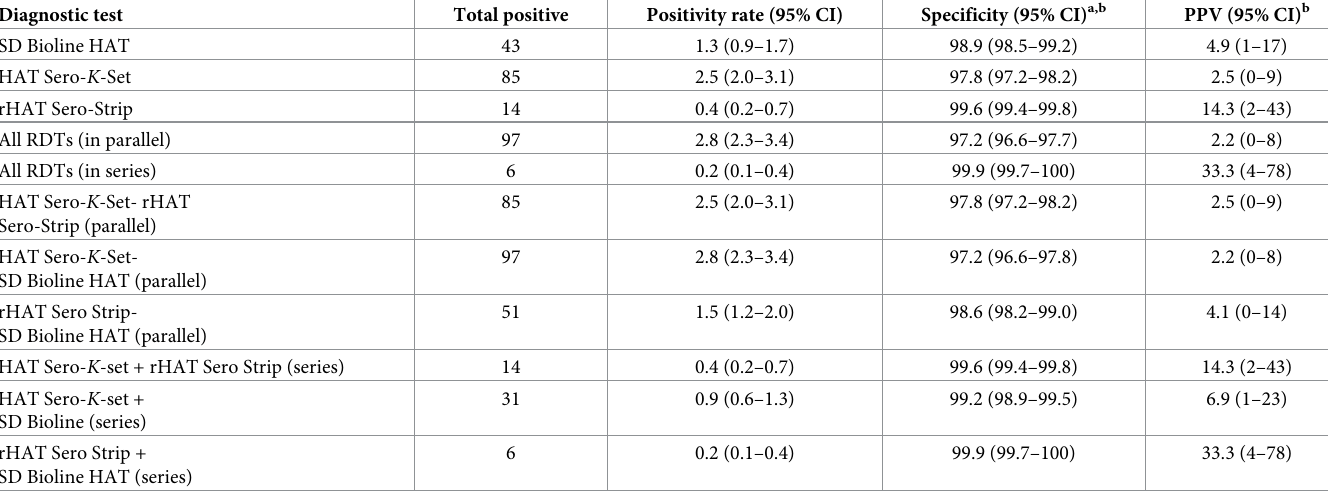
Table 3. Performance of the different rapid diagnostic tests for HAT using the parasitological test as gold standard.